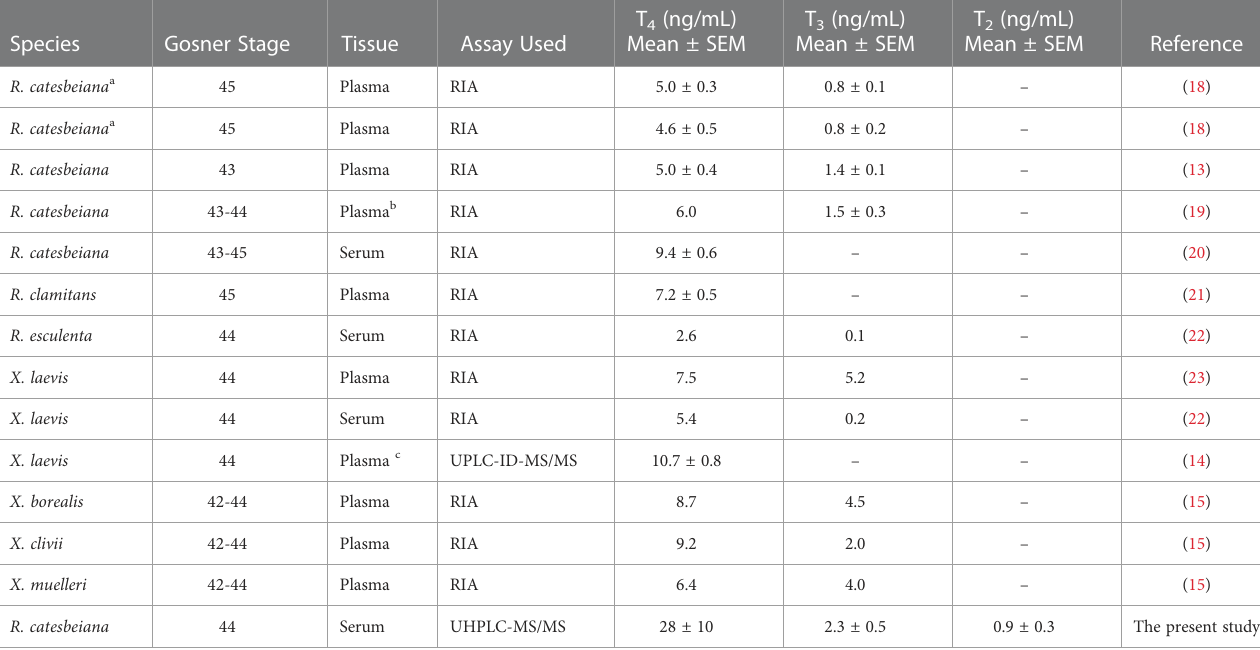
TABLE 1 Summary of maximal levels of THs (ng/mL) measured during metamorphosis in published studies.